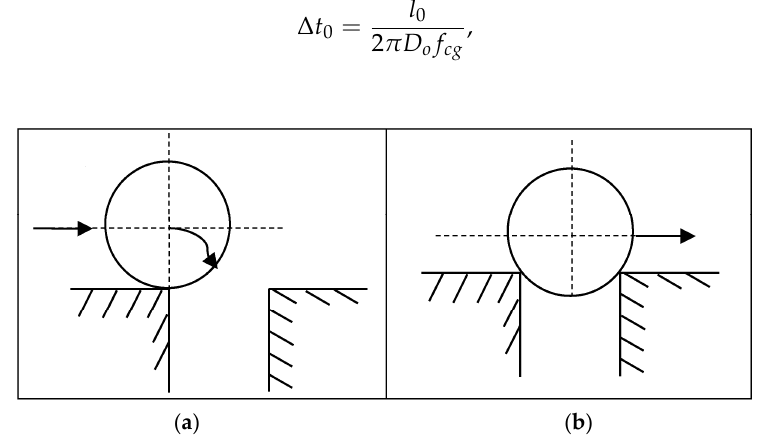
Figure 4. Schematic diagram of rolling element fault position. ( a ) Schematic diagram of the rolling element entering the fault location; ( b ) Schematic diagram of the rolling element leaving the fault location.